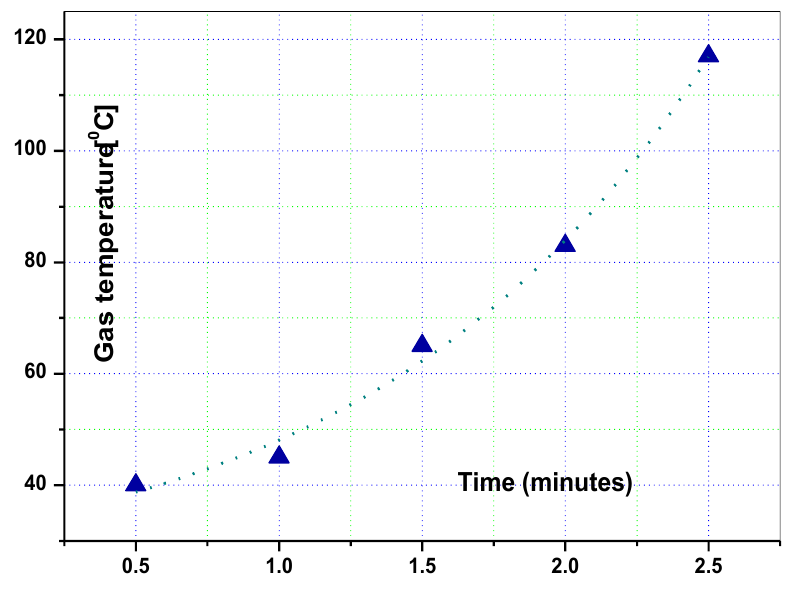
Figure 10. Gas temperature as function of